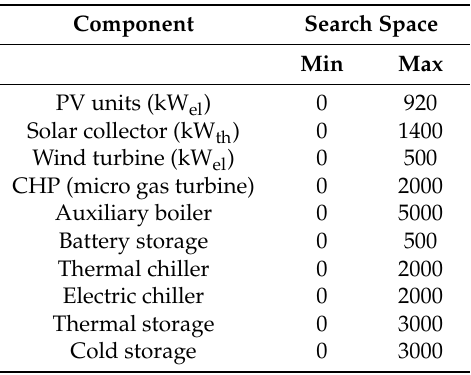
Table 6. Optimization search